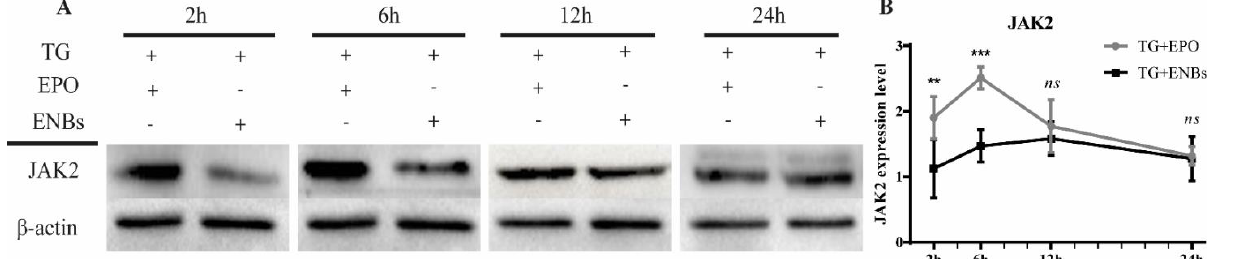
Figure 4. Janus kinase 2 expression ( A ) determined by Western blot analysis and ( B ) quantified over 24 h. β-Actin was used as a loading control. TG indicates thapsigargin treatment, TG + EPO indicates thapsigargin and EPO cotreatment, and TG + ENBs indicates thapsigargin and EPO nanobot cotreatment. JAK2, Janus kinase 2. ** p < 0.01, *** p < 0.001, and ns, not significant versus TG + EPO cotreatment.